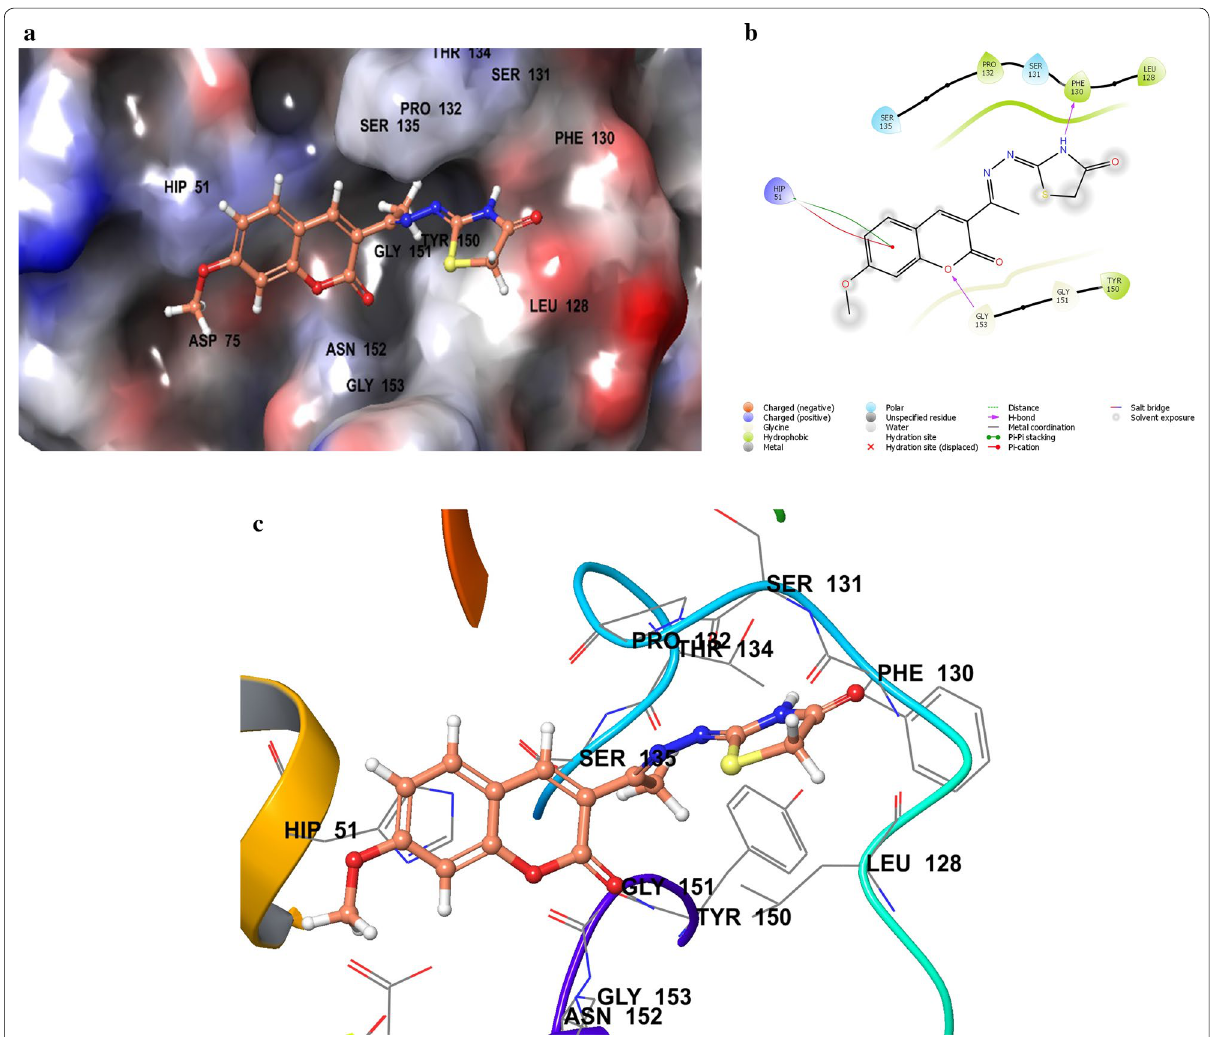
Fig. 9 Binding modes of compound SKYe with dengue virus NS2B/NS3 protease: a Protein as surface and compound as sticks; b Protein and compound as 2D interaction image; c Protein as ribbon and compound as